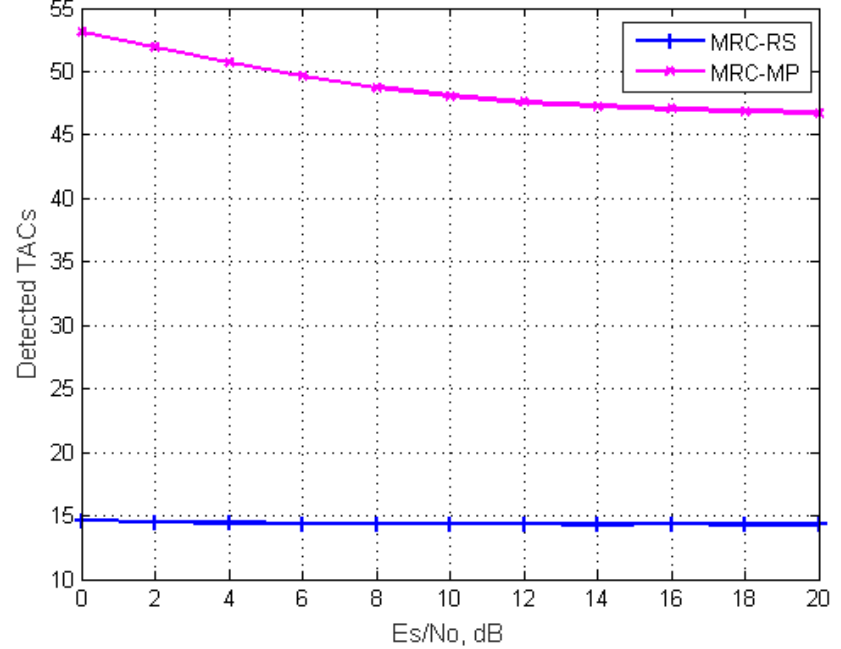
Figure 9. Average number of TACs finally detected by MRC-RS and MRC-MP detectors when N t = 16, N r = 16, M = 16 and N p = 2.